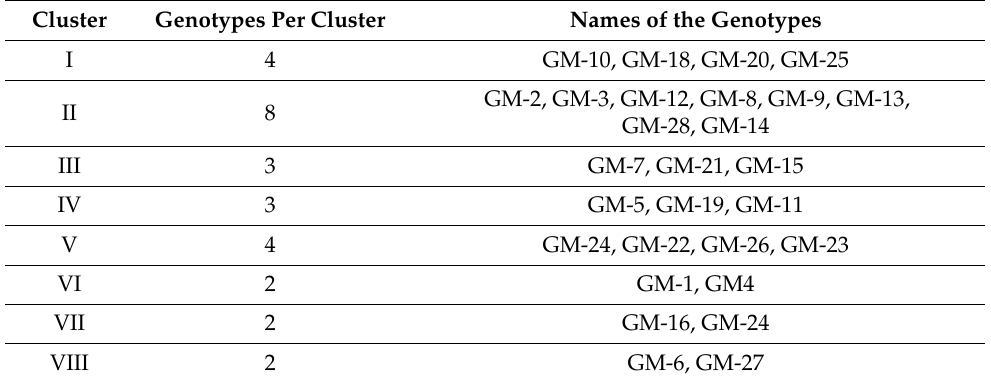
Figure 2. Divergent groups of vegetable soybean genotypes were grouped into cluster I (1) to cluster VIII (8) segregated by cluster distances indicating that cluster I and cluster-VIII depicted maximum genetic divergence. Table 3. Cluster composition based on D 2 statistics in vegetable